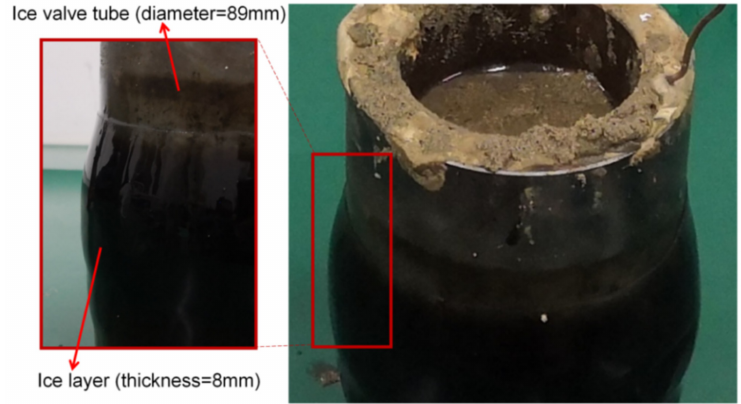
Figure 8. Ice layer outside the ice valve tube.